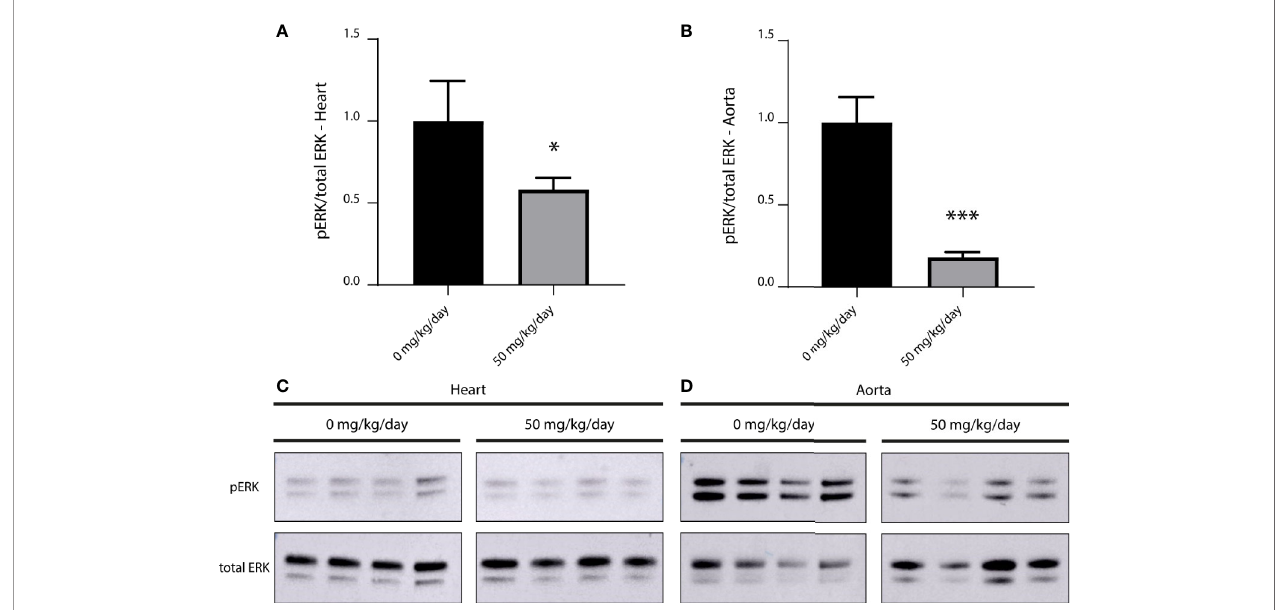
FIGURE 5 | Inhibitory effect of refametinib on ERK activation in murine myocardial and aortic tissue. Refametinib strongly suppressed pERK levels in myocardial (A) and aortic (B) tissue of mice treated for 7 days with 50 mg/kg/day refametinib supplemented drinking water compared to untreated mice. pERK expression was calculated based on the total ERK expression after which values were normalized to the mean value of untreated mice. Western blots of pERK and total ERK levels in myocardial (C) and aortic (D) tissue at indicated doses of refametinib supplemented drinking water. Samples represent biological replicates. * independent two- sample t-test, p = 0.0169, *** independent two-sample t-test, p <